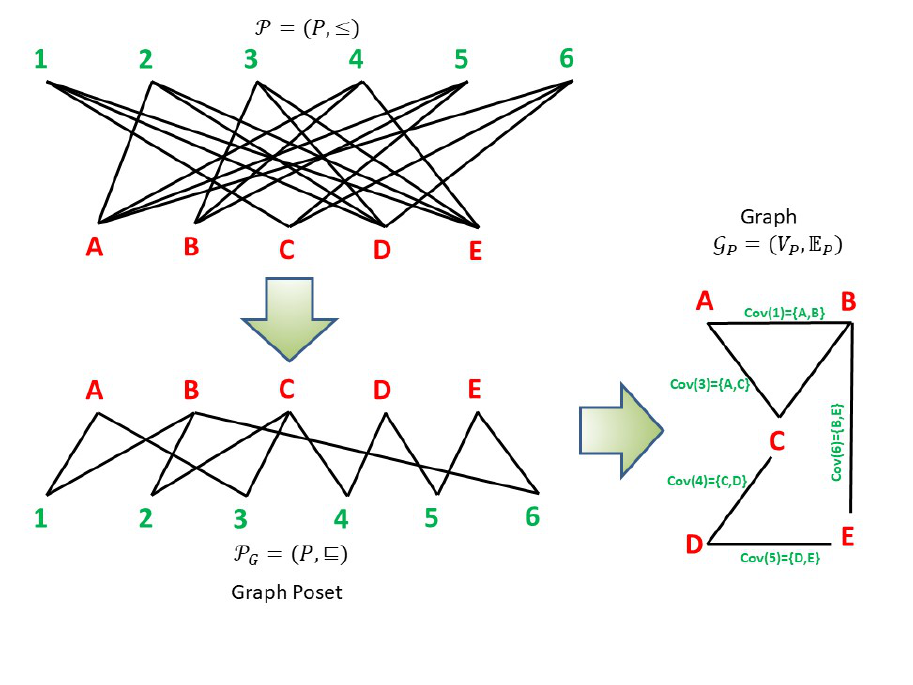
Figure 10 The Graph Poset and Graph Associated with an Anti-Graph